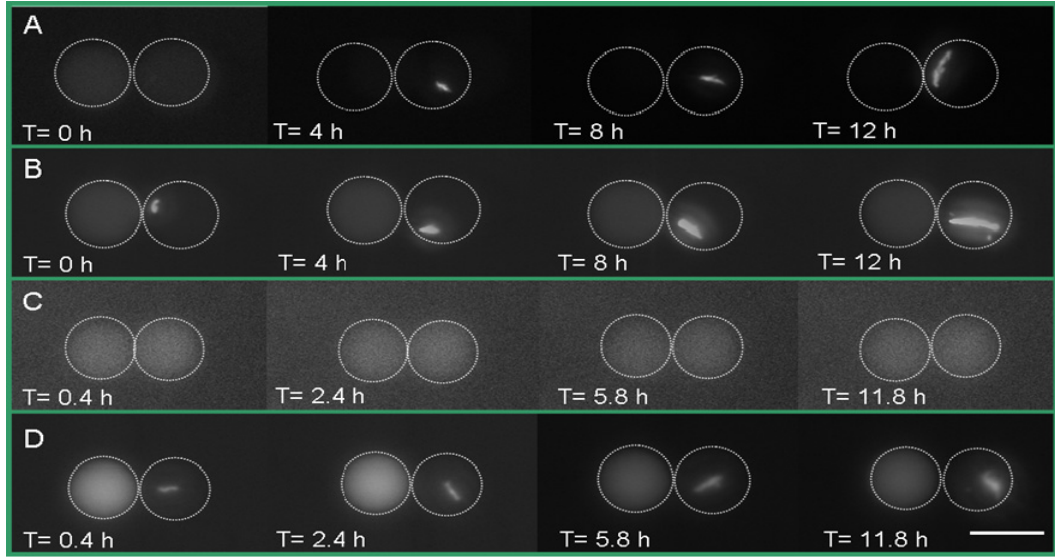
Figure 2. LasR-expressing E. coli responding to the signaling molecule, OdDHL and the negative control experiment. ( A ) The left droplet contains rhodamine B isothiocyanate-dextran (500 nM) and OdDHL (1 µM). The right droplet contains LasR-expressing E. coli . Fluorescent images show an increase in green fluorescence protein (GFP) fluorescence in bacteria as a function of time; ( B ) RFP production in the same compartmentalized single bacterium shown in A; ( C ) The left droplet contained rhodamine B isothiocyanate-dextran (500 nM) without OdDHL and the right droplet contained LasR-expressing E. coli . No production of GFP was observed in the green fluorescent images; ( D ) RFP production in the same single bacterium shown in C. The white circles indicate the boundary of the droplets. Scale bar: 50 μ